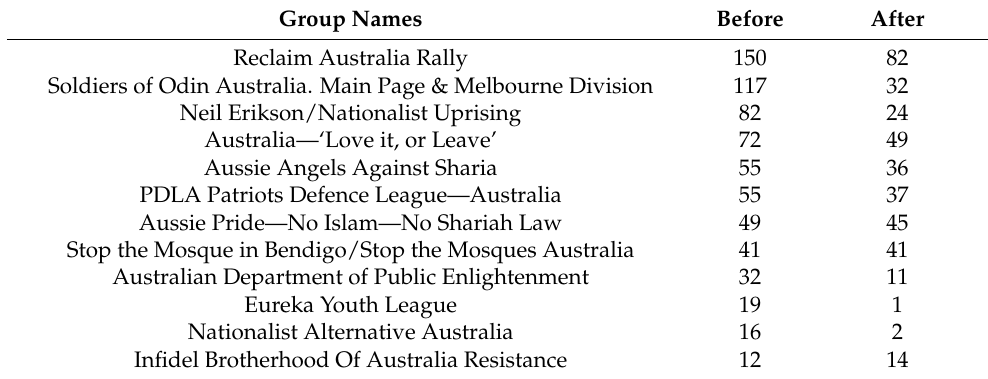
Table 1. Number of users active in other Australian far-right Facebook pages before and after the march.